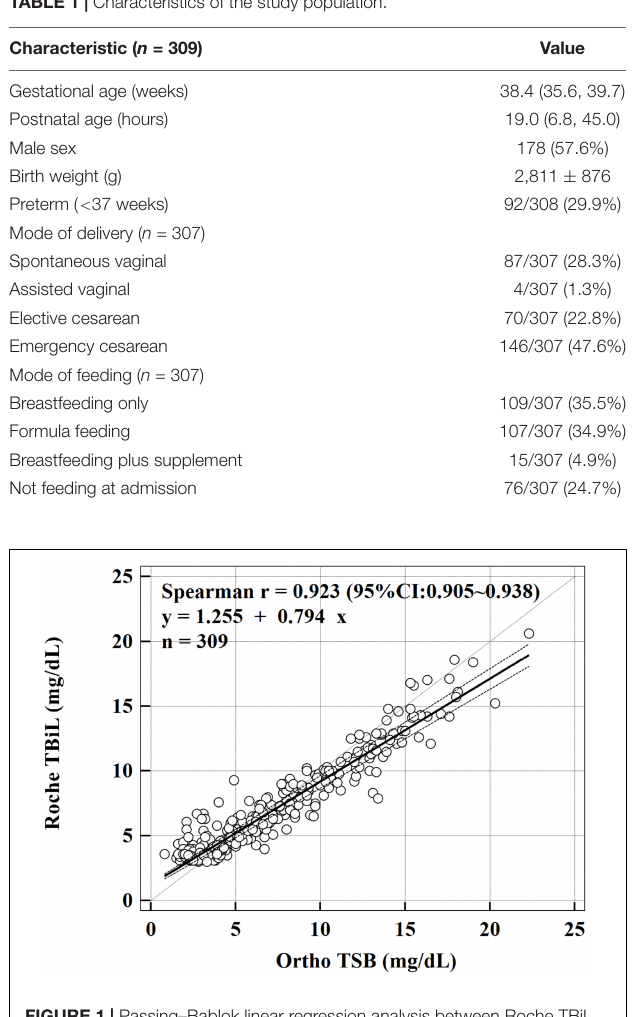
FIGURE 1 | Passing–Bablok linear regression analysis between Roche TBiL and Ortho TSB. The solid line is the line of best fit, and the dashed lines reflect the 95% CI. The dotted line represents the line of equivalence. The regression equation is Roche TBiL = 0.794 × Ortho TSB + 1.255 mg/dL.